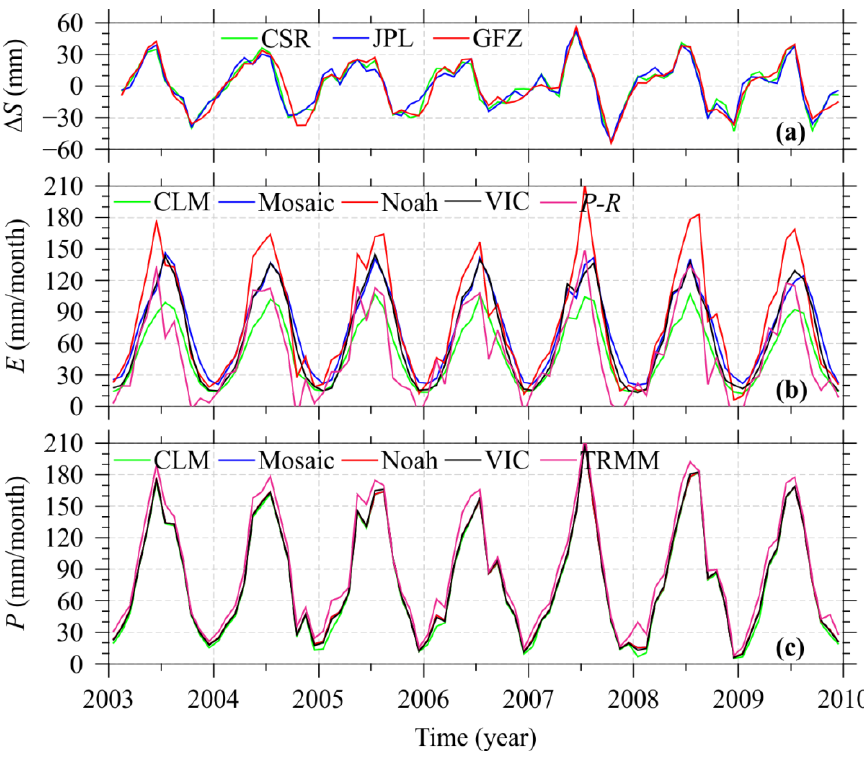
Figure 4. ( a ) Monthly Gravity Recovery and Climate Experiment (GRACE)-derived water-storage changes from the three different processing centers (Center for Space Research (CSR), Jet Propulsion Laboratory (JPL) and GeoForschungsZentrum (GFZ)); ( b ) Monthly evaporations from four versions of Global Land Data Assimilation System (GLDAS) (CLM, Mosaic, Noah and VIC) and those estimated by P − R ; ( c ) Tropical Rainfall Measurement Mission (TRMM) precipitation and those estimated by GLDAS (CLM, Mosaic, Noah and